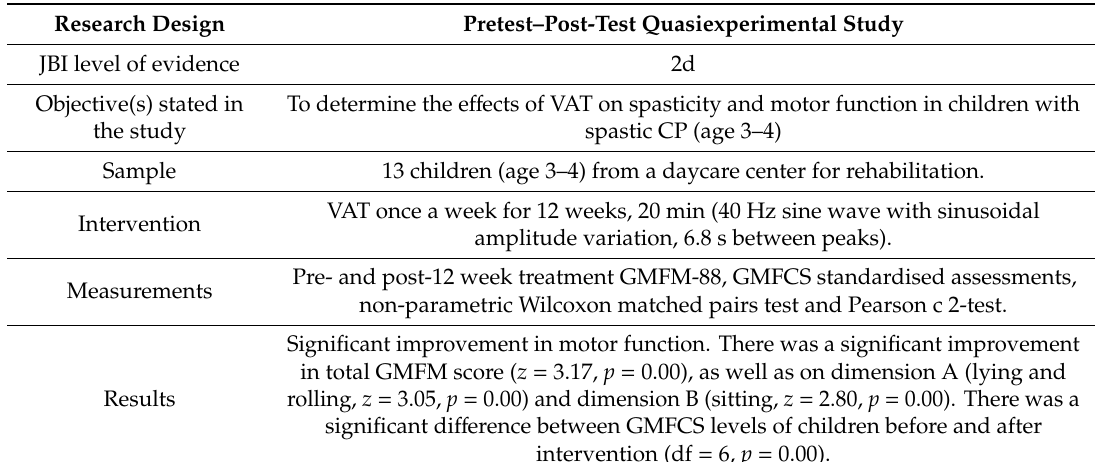
Table 5. Studies on children with CP—Katusic and Mejaski-Bosnjak [43]. Research